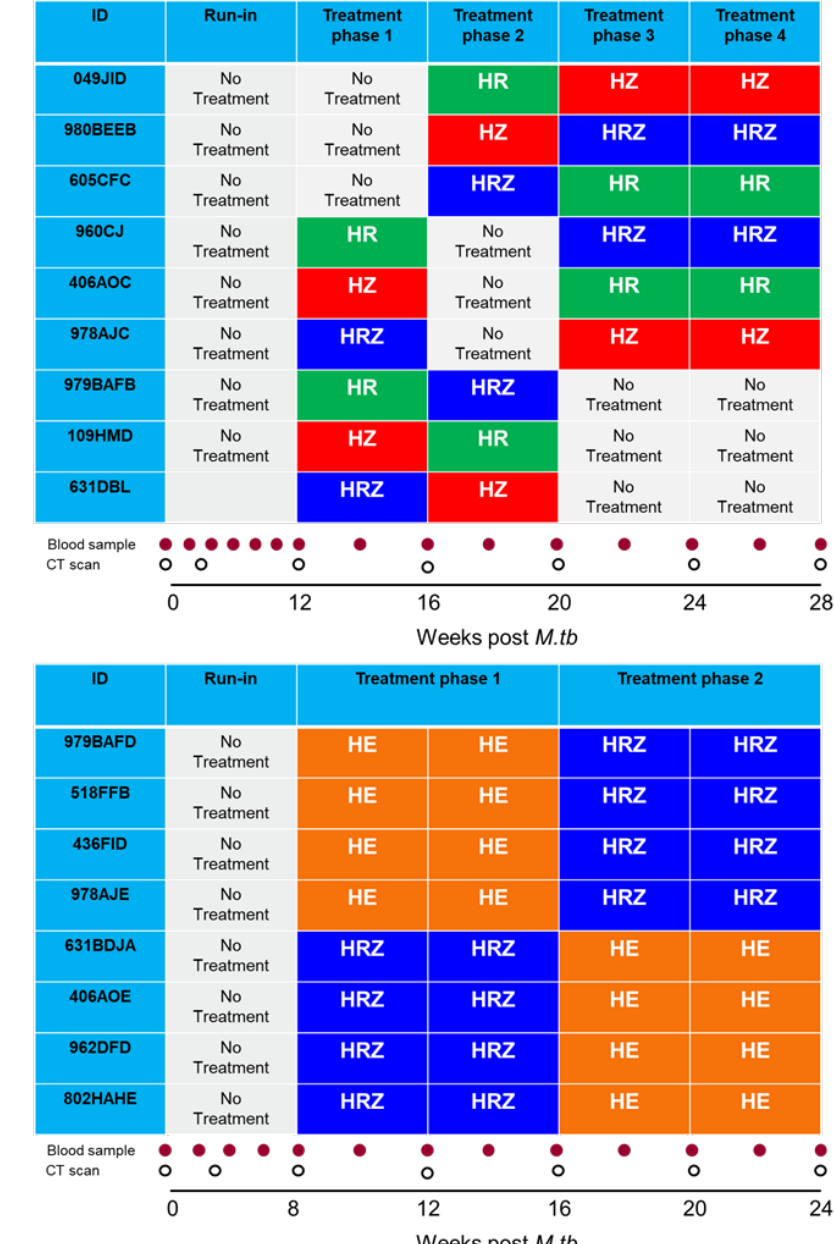
Figure 1. Study plans showing the treatment phases, blood sampling schedules and CT scan collec- tion points used in PK/PD Study 1 ( A ) and 2 ( B ). HE (Isoniazid, Ethambutol); HRZ (Isoniazid, Ri- fampicin, Pyrazinamide); HZ (Isoniazid, Pyrazinamide); HR (Isoniazid,